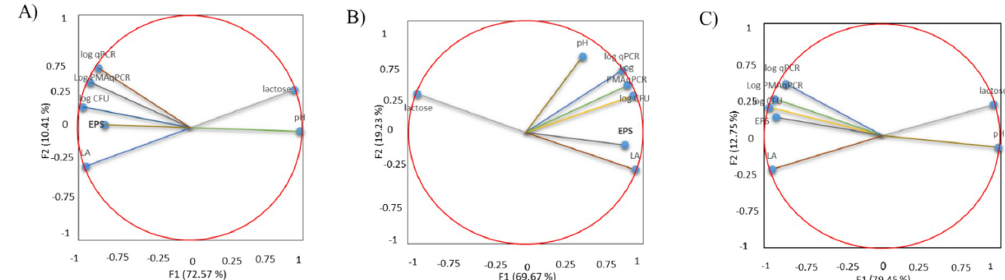
Figure 3. Principal component analysis (PCA) on the basis of growth, viability, pH, sugar consumption, lactic acid and exopolysaccharide production for L. rhamnosus R0011 ( A ); ATCC 9595 ( B ) and RW-9595M ( C ). Log CFU = viable cultivable counts in CFU / mL, log qPCR = total counts by qPCR and log PMA-qPCR = by PMA-qPCR in viable cells / mL; lactose, LA = lactic acid; pH and exopolysaccharides =